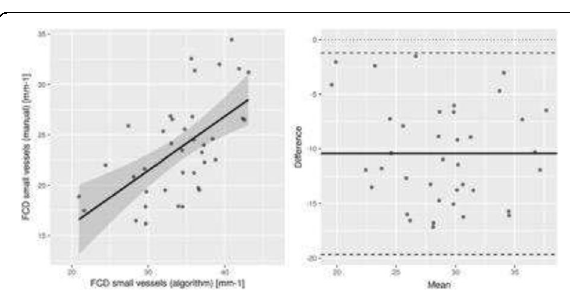
Fig. 2 (abstract 0333) Correlation of per video FCD as determined manually and using advanced computer